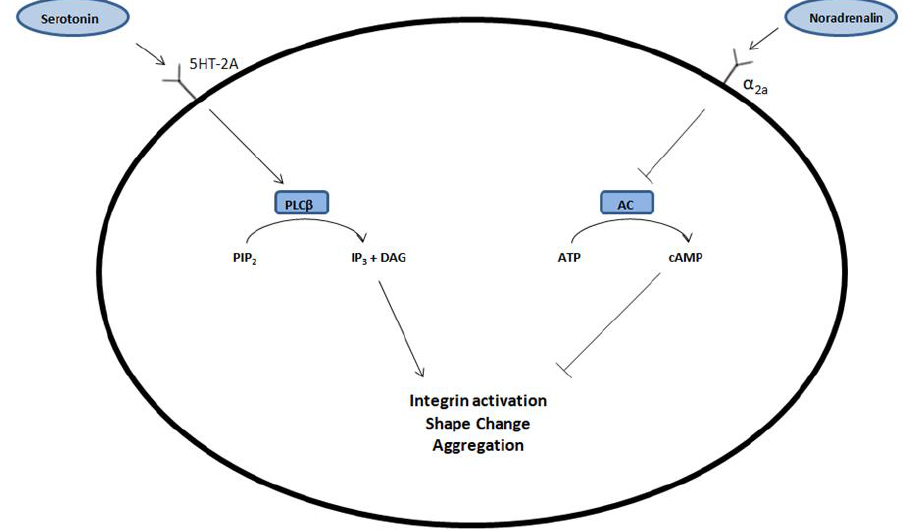
Figure 1. By binding to the 5HT-2A receptor on the surface of the blood platelets, serotonin (5-HT) causes an increase in the concentration of phospholipase Cβ (PLCβ). It causes conversion of phosphatidylinositol-4,5-bisphosphate (PIP2) to inositol-1,4,5-trisphosphate (IP¬3), which activates integrin, changes shape of platelets, and at the end, causes an aggregation process. Noradrenalin (NA) exerts the same effect but by activating the α2a receptor, which inhibits adenylate cyclase (AC) and lowers the cAMP concentration. This process inhibits platelet aggregation. DAG — diacylglycerol.